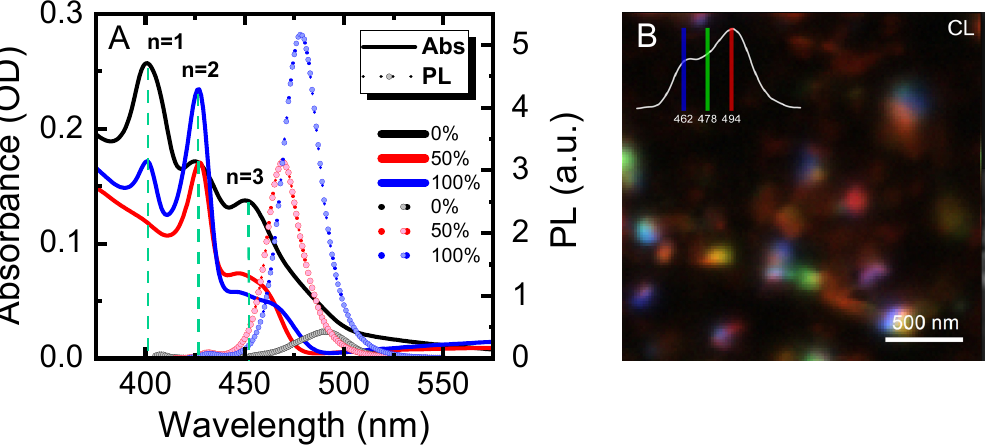
Figure 2. ( A ) Absorbance (solid lines) and PL (dashed lines) spectra of quasi-2D Rb–Cs-alloyed lead bromide perovskites with varying excesses of RbBr. Excitonic peaks in the absorption spectra are labelled, indicating the corresponding quasi-2D domains. ( B ) Cathodoluminescence image of the sample with 0% excess RbBr. The image is artificially colored in RGB primaries and displayed in its original 128 × 128-pixel grid. The correspondence between the luminescence wavelength and the pixel color is shown in the inset. The scalebar is shown on the bottom right.